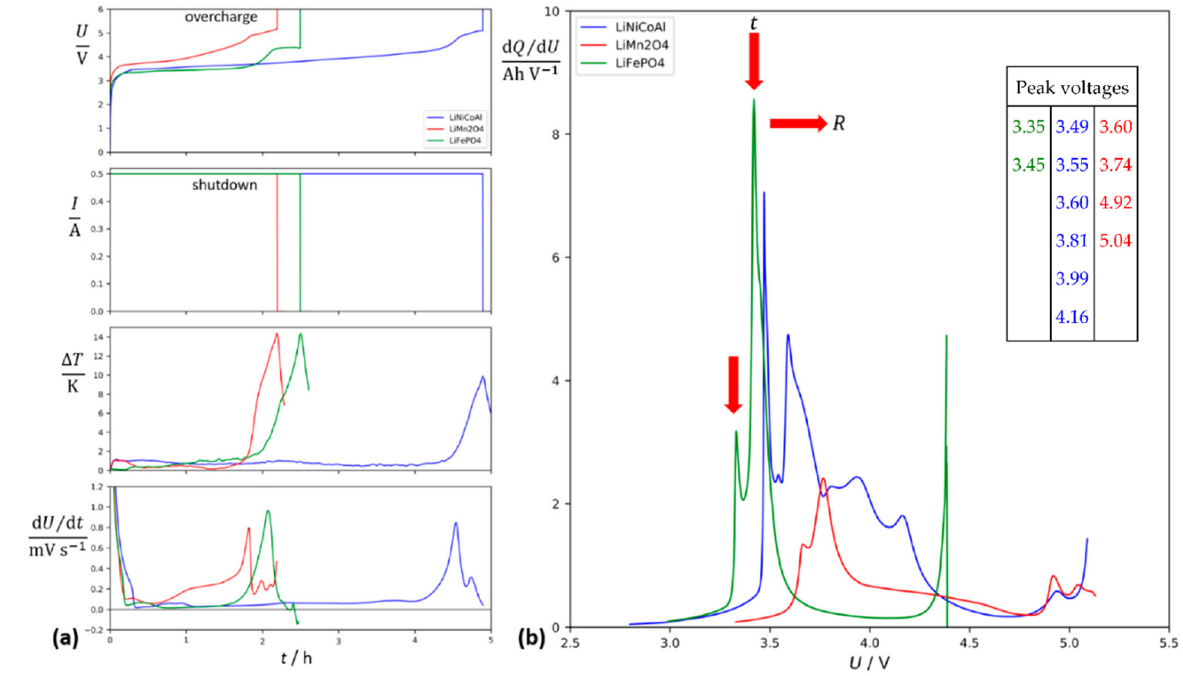
Figure 7. Constant current overcharge of different lithium-ion batteries: ( a ) cell voltage U , current I , temperature change Δ T with time t . ( b ) Rise of differential capacity as a criterion for full charge (SOC = 1) and failure by overcharging (SOC > 1 for U ≫ 4 V). The red arrows qualitatively show the lower peak height due to the loss of active material (aging time t ) and the peak shift due to the rising cell resistance R .—Panasonic NCR18500A (LiNiCoAl), —Sony US14500VR2B (LiMn 2 O 4 ), —IFR 18,500 (LiFePO 4 ).